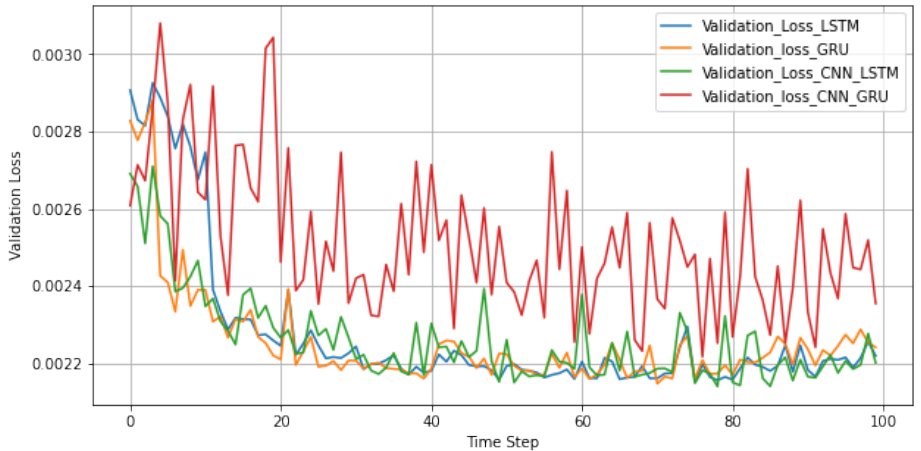
Figure 7. Validation loss comparison among the different models under